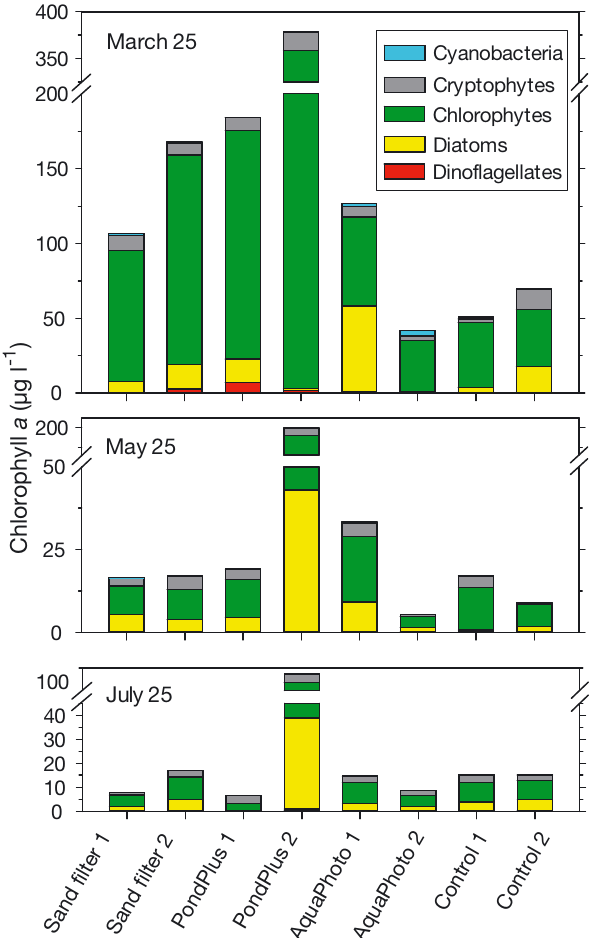
Fig. 2. Concentrations of chlorophyll a and composition of major groups of phytoplankton in the ponds determined by pigment and CHEMTAX analyses. For each sampling, result from 1 filter is